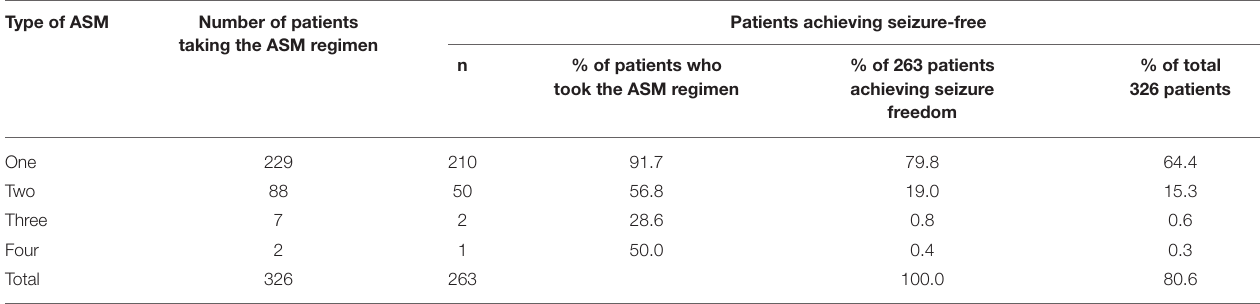
ASM, antiseizure